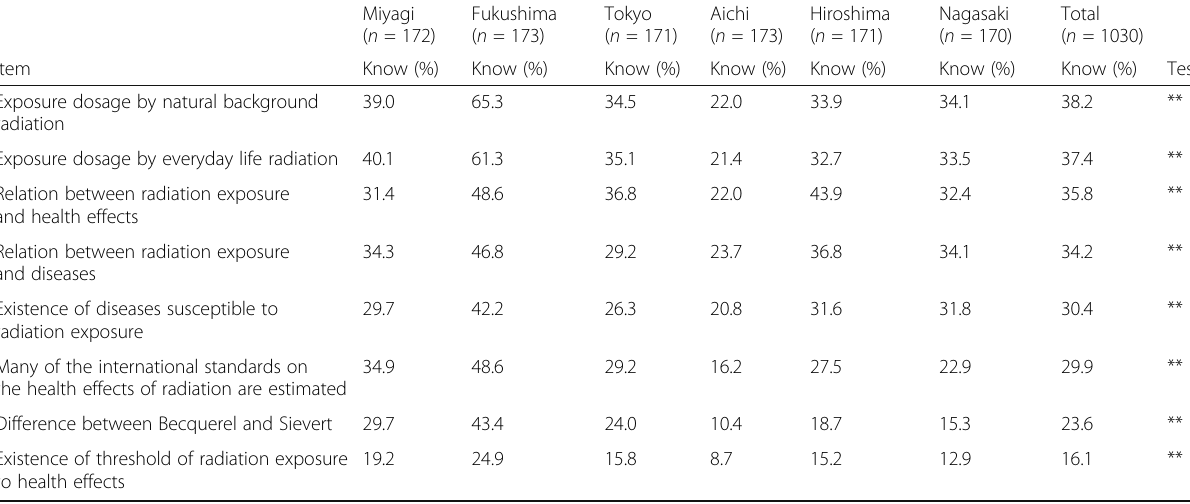
Table 6 Difference in the percentage of “ Know ” on the recognition level of the meanings of eight technical issues regarding radiation among residents of the six